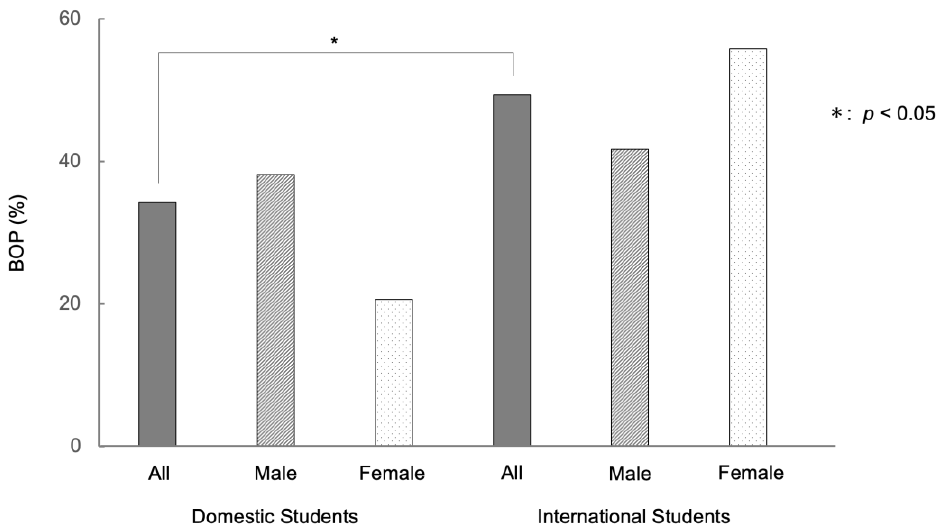
Figure 2. Differences of bleeding on probing (BOP) between international and domestic university students in Japan. Note: The international students showed higher percentage of BOP than domestic students (49.4% and 34.2%, respectively: p < 0.05).